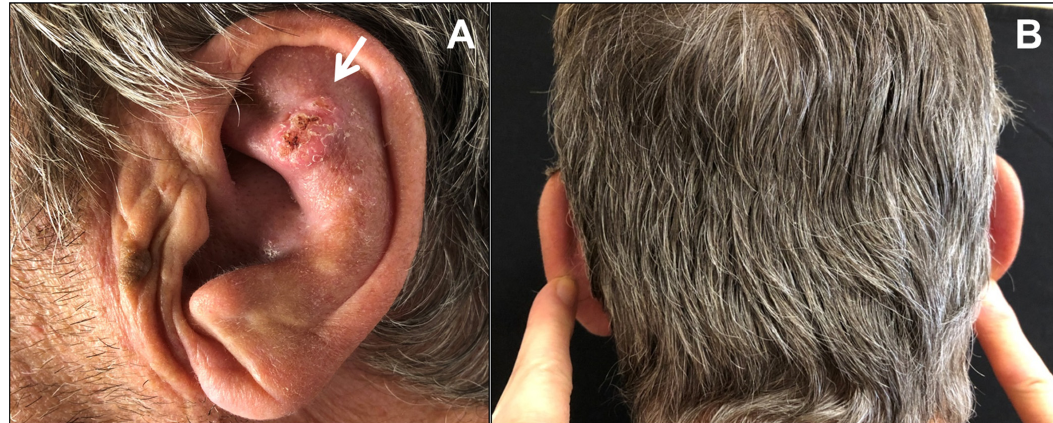
Figure 1. ( A ) Petrified ear with squamous cell carcinoma (arrow); ( B ) Digital probing detects inflexible stiffness in both ears.